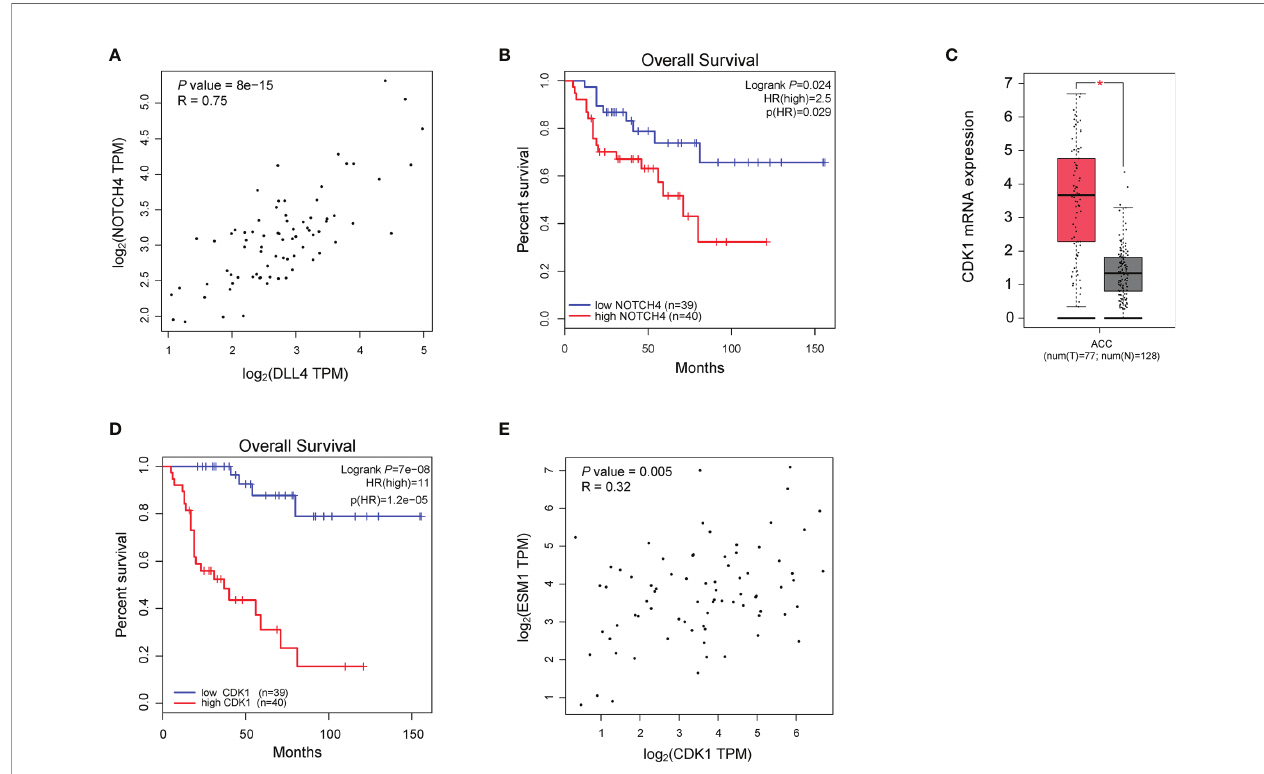
FIGURE 6 | The analysis of potential signaling pathway in ACC patients with ESM1 high versus ESM1 low . (A) The correlation between the expression of DLL4 and Notch4 in ACC. (B) The OS of ACC patients with Notch4 high or low expression. The expression (C) and OS (D) of CDK1 in ACC patients. (E) The correlation between the expression of ESM1 and CDK1 in ACC. * p <